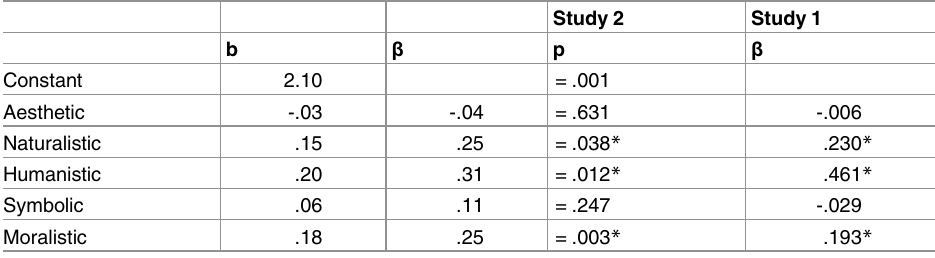
Table 13. Value of engagement nature indicators as predictors of nature